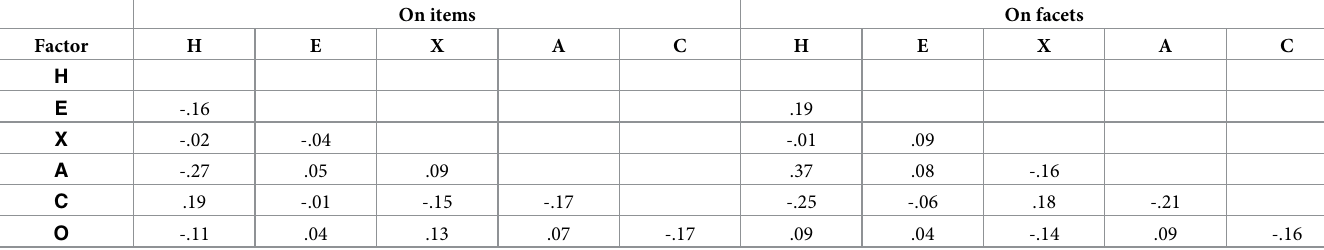
selection of a total of 190 items that correspond to the 190-item version of the HEXACO-M- SI-E (see Table A in S1 File).